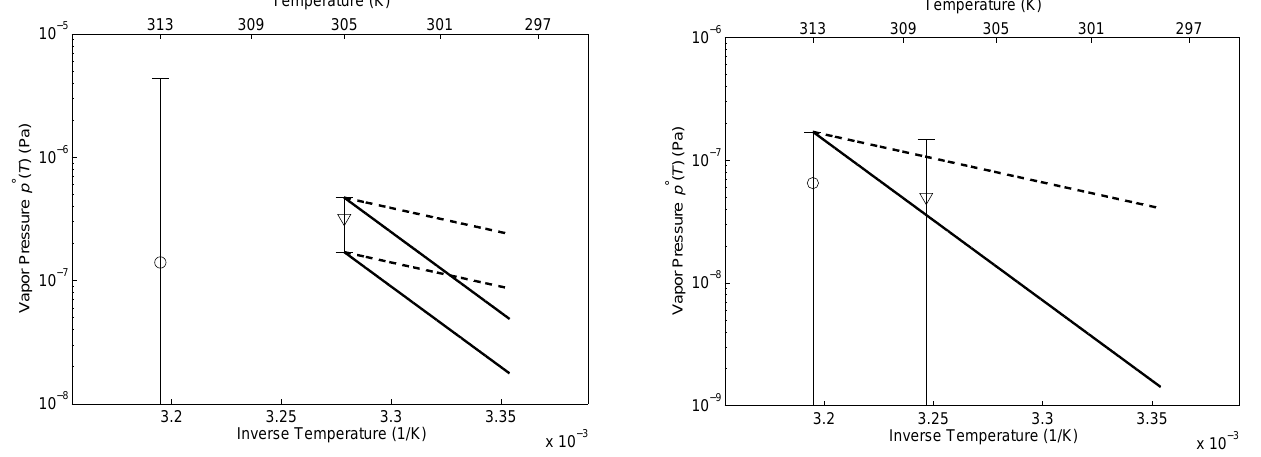
Fig. 7. Pure component vapor pressure p ◦ ,L of citric acid (open symbols, denoting two different particles). Both measurements were indistinguishable from zero. The measured upper limit at T ≈ 311K is extrapolated to yield the upper limit at T (cid:9) using 1H (cid:9) vap of 75 (dashed) or 250 (solid)kJmol − 1